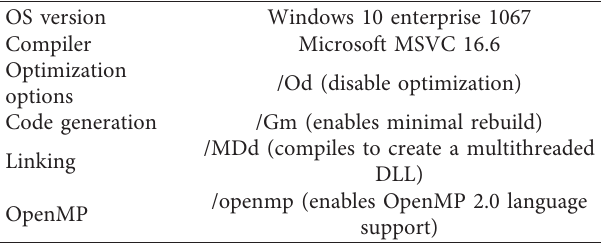
Table 4: Software experimental